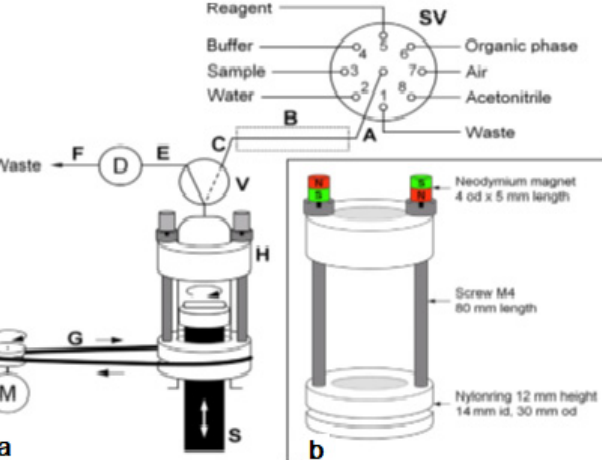
Figure 4. ( a ) Analyzer manifold with selection valve (SV), syringe pump (S), solenoid 3-way head valve (V), detection flow cell (D), heating device integrated into the HC (B) and the magnetic stirring bar driver (H) placed onto the syringe barrel. A motor (M) is used to drive it via a rubber band (G). PTFE tubing (0.8 mm i.d.) of 15 cm (A,C), 10 cm (E), and 40 cm (F): 10 cm.; ( b ) The magnetic stirring bar driver placed onto the syringe glass barrel shown in detail [27].